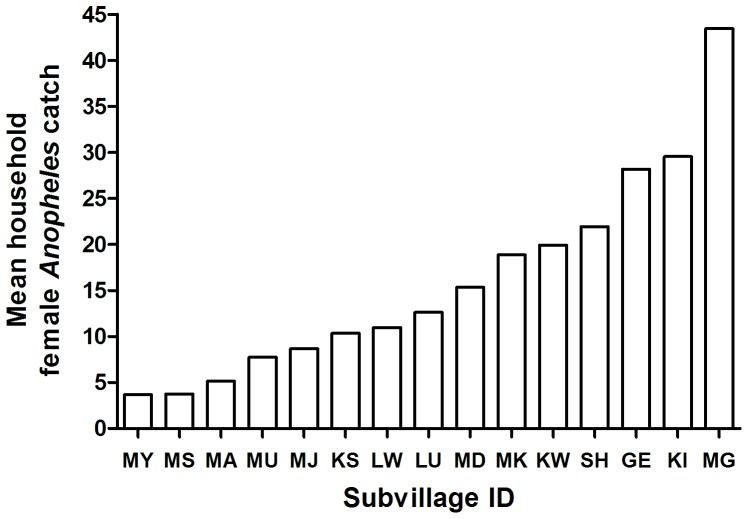
Mean household Anopheles female count during peak transmission (May) in different subvillages.Numbers of households sampled for each subvillage, in order of Anopheles exposure, were as follows: MY = 45, MS = 23, MA = 26, MU = 21, MJ = 29, KS = 24, LW = 65, LU = 61, MD = 45, MK = 14, KW = 99, SH = 13, GE = 47, KI = 30, MG = 91.